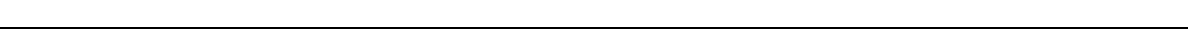
Fig. 5 The transcriptional changes associated with the loss of PU.1 and SpiB. Resting lymph node B cells from mice of the indicated genotype were cultured in the presence of CD40 L + IL-4 for 48 h. RNA was extracted and whole transcriptome sequencing performed on duplicates of each cell population. a The read coverage showing deletion of exon 5 of Spi1 (PU.1) and exon 6 of Spib in the appropriate genotypes is shown mapped to the exon-intron structure. b , c The number of differentially expressed (DE) genes (de fi ned as log 2 fold change > 0.6-fold, log 2 RPKM (reads per kilobase of exon model per million mapped reads) > 0, P < 0.15) identi fi ed for each genotype is shown relative to control B cells. Genes upregulated in the absence of the indicated transcription factor(s) are shown by bars above the line while genes down regulated are shown below. Values indicate the number of DE genes from SpiB KO cells. The identity of the DE genes is provided in Supplementary Data. b Orange bars show the number of DE genes common between the PU.1 cKO and PU.1 SpiB DKO genotypes. c Blue bars show the number of DE genes that have PU.1 peaks ( P < 10 − 6 ). P -values indicate the enrichment of PU.1 binding in down regulated DE genes compared to the total binding of PU.1 in non-DE genes using a Chi-square test. **** P < 0.0001. d The expression (in RPKM) of important regulators of mature B cell and antibody-secreting cell biology is shown for each of the four genotypes examined. *Indicates genes that are DE relative to controls (as de fi ned in a ). Gene names with PU.1 peaks ( P < 10 − 6 ) are indicated in red. e KEGG pathway analysis of genes regulated by PU.1 and PU.1/SpiB. Genes were fi rst divided into those that were down or upregulated in the indicated genotypes. The number of genes that are associated with each statistically enriched ( P < 0.05) functional category is